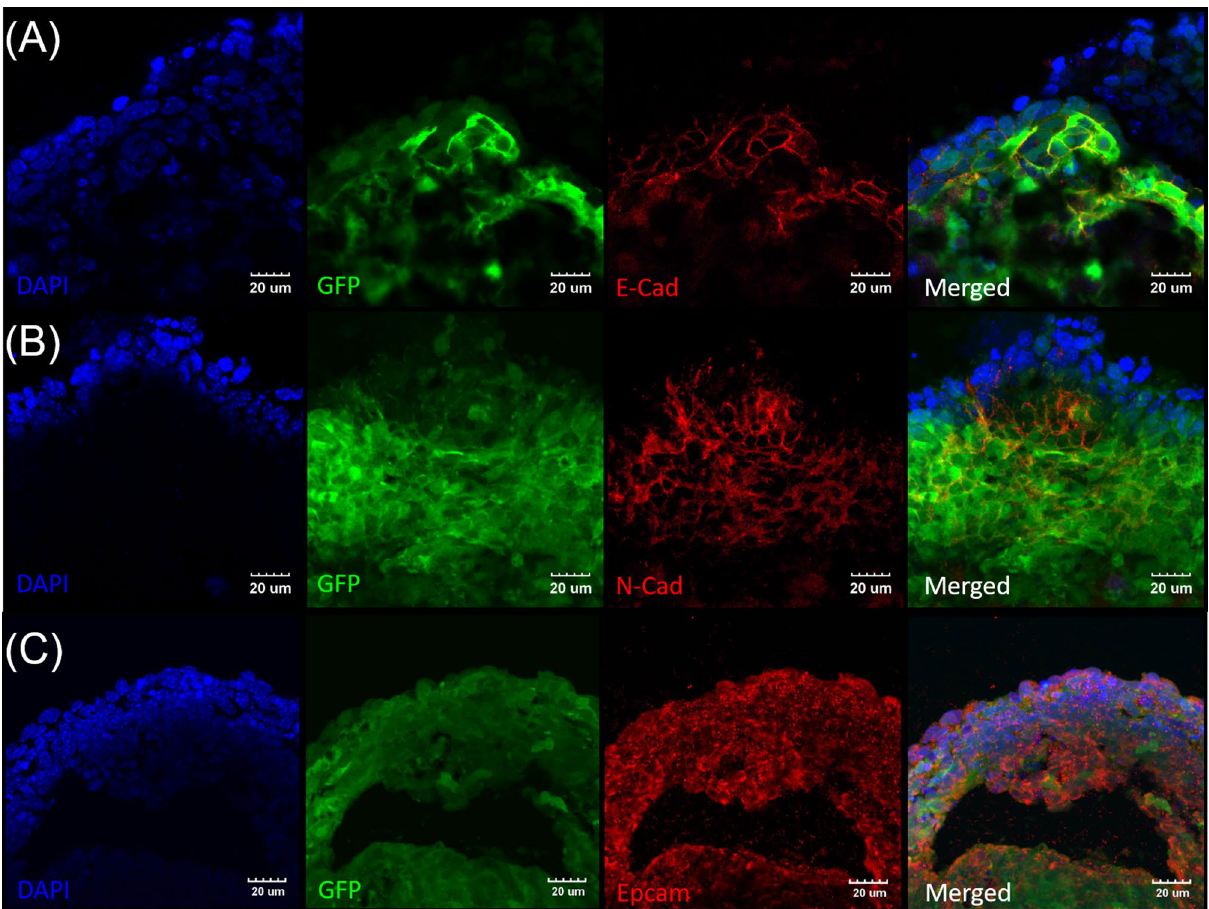
Figure 3. Contact co-culture of ESC-EBs with HEI-OC1 cells generated prosensory epithelia. EBs from contact co-culture were isolated after 14 days and sectioned and stained for the presence of ectodermal differentiation. Representative high magnification images of ( A ) EB showing sparse expression of GFP + /E-Cad + cells. ( B ) Patches of GFP + /N-Cad + expression within the co-cultured EBs. ( C ) GFP + /Epcam + expression within